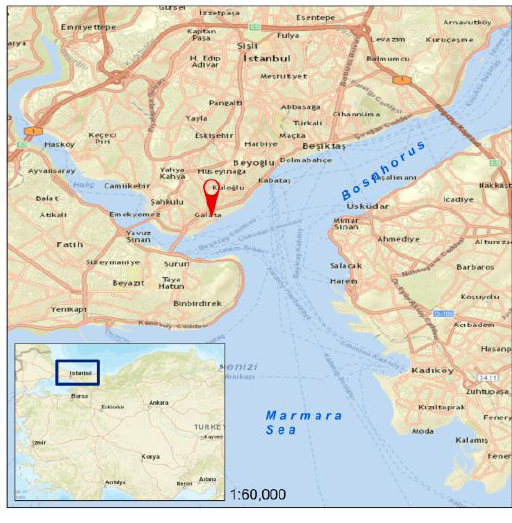
Figure 2. Study area